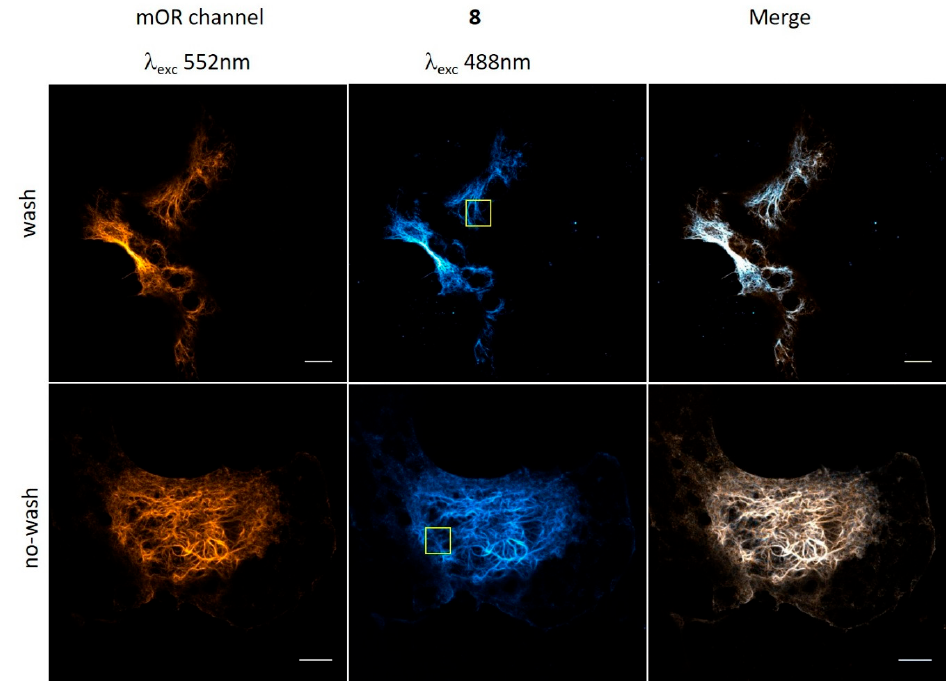
Figure 2. Confocal microscopy images of Vim Lys- BCN -mOrange expressing COS-7 cells labeled with 8 (washed and no-washed schemes). Scale bar: 10 μ m. Yellow squares indicate the magnified area presented in Figure 3.